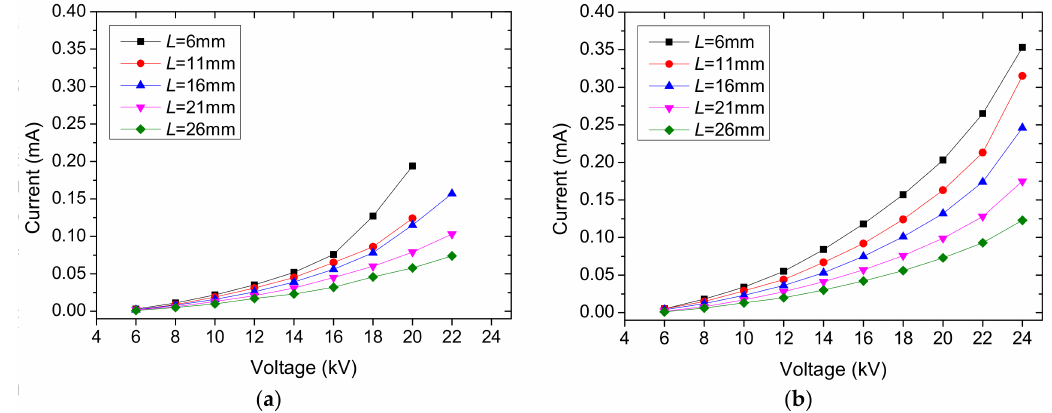
Figure 9. Variation of discharge current with the applied voltage with different needle-ring distances for five needles: ( a ) positive corona discharge; and ( b ) negative